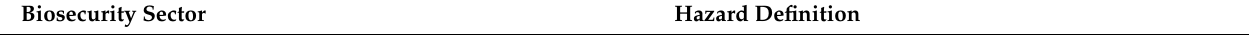
Table 1. Examples of different types of hazards applicable to different biosecurity sectors (Adapted from FAO, 2007